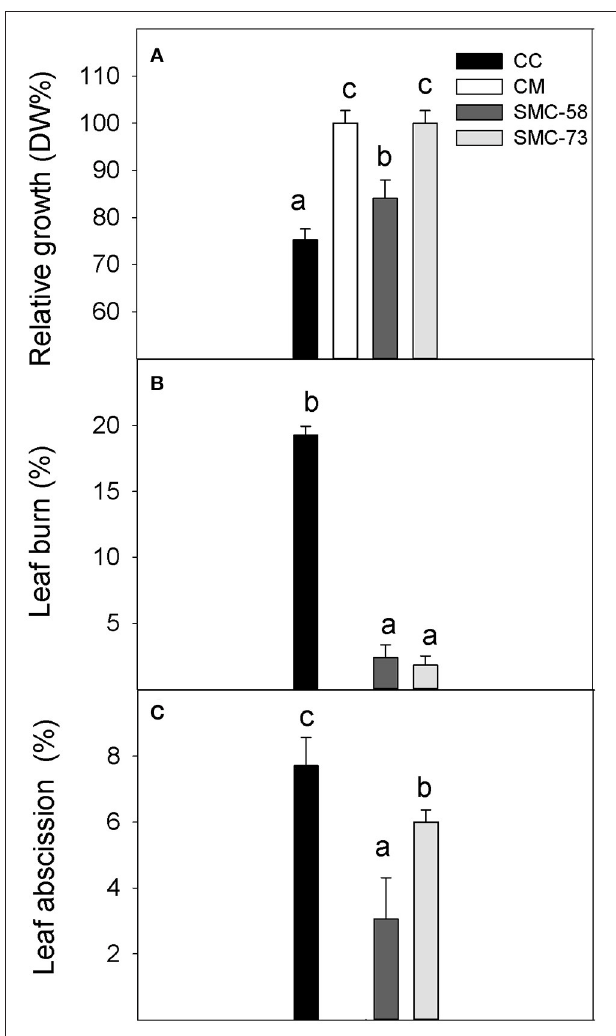
FIGURE 6 | Influence of salinity on Carrizo citrange (CC), C. macrophylla (CM) and somatic hybrids SMC-58 and SMC-73 plants. (A) Relative growth (DW %), (B) Leaf burn damage (%) and (C) Leaf abscission. Plants were cultivated for 20 days under glasshouse conditions and saline treatment (40mM NaCl). Values are the mean of six plants ( n = 6) and standard error. Different letters indicate significant differences for P ≤ 0.05 on Duncan’s multiple range